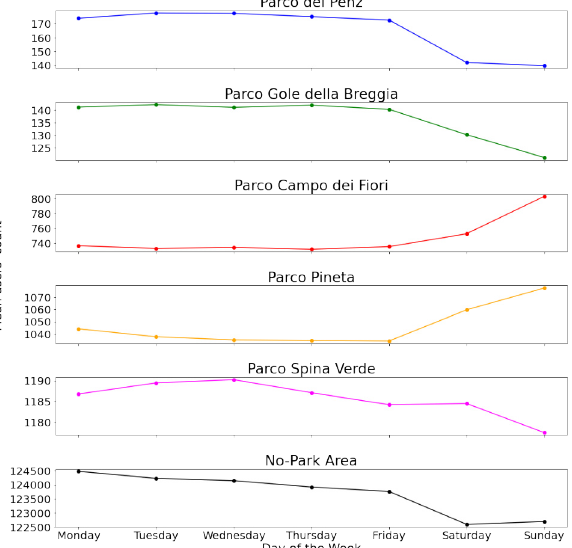
Figure 4. Variation of Facebook mean users’ population count per day of the week in the Insubria parks and surrounding areas for the period May 2020-December 2021. Illustration by (Oxoli et al., 2022b) licensed under CC BY